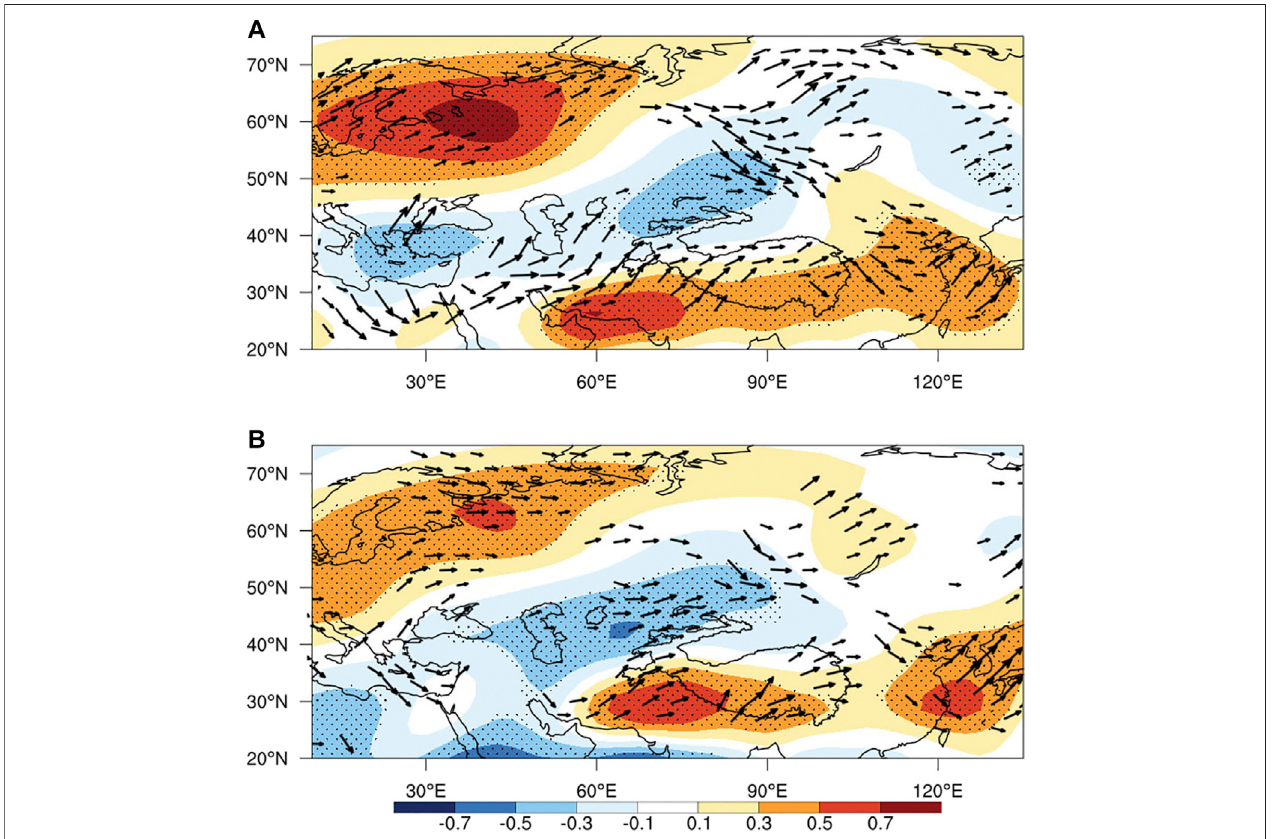
FIGURE 8 | Correlation coef fi cients between 500-hPa geopotential height and WAF in summer and (A) the PC1 of winter snow cover and (B) the PC1 of summer CHDEs.Blackdotsandblackvectorsindicatevaluessigni fi cantatthe95%con fi dencelevel.ApositivecorrelationforzonalormeridionalWAFcomponentisdenotedby an eastward or poleward arrow,